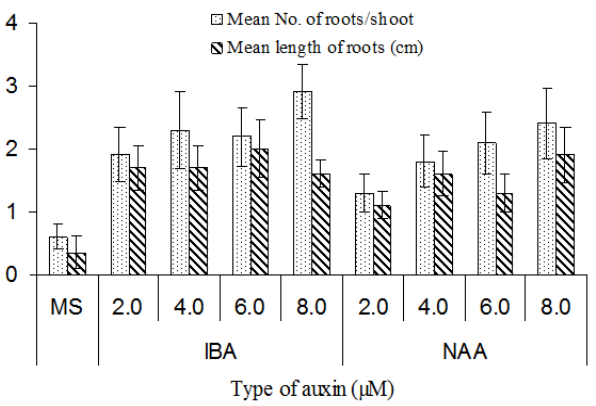
Fig. 2. Effects of auxins (IBA and NAA) on adventitious rooting of in vitro derived microshoots of A. mangium